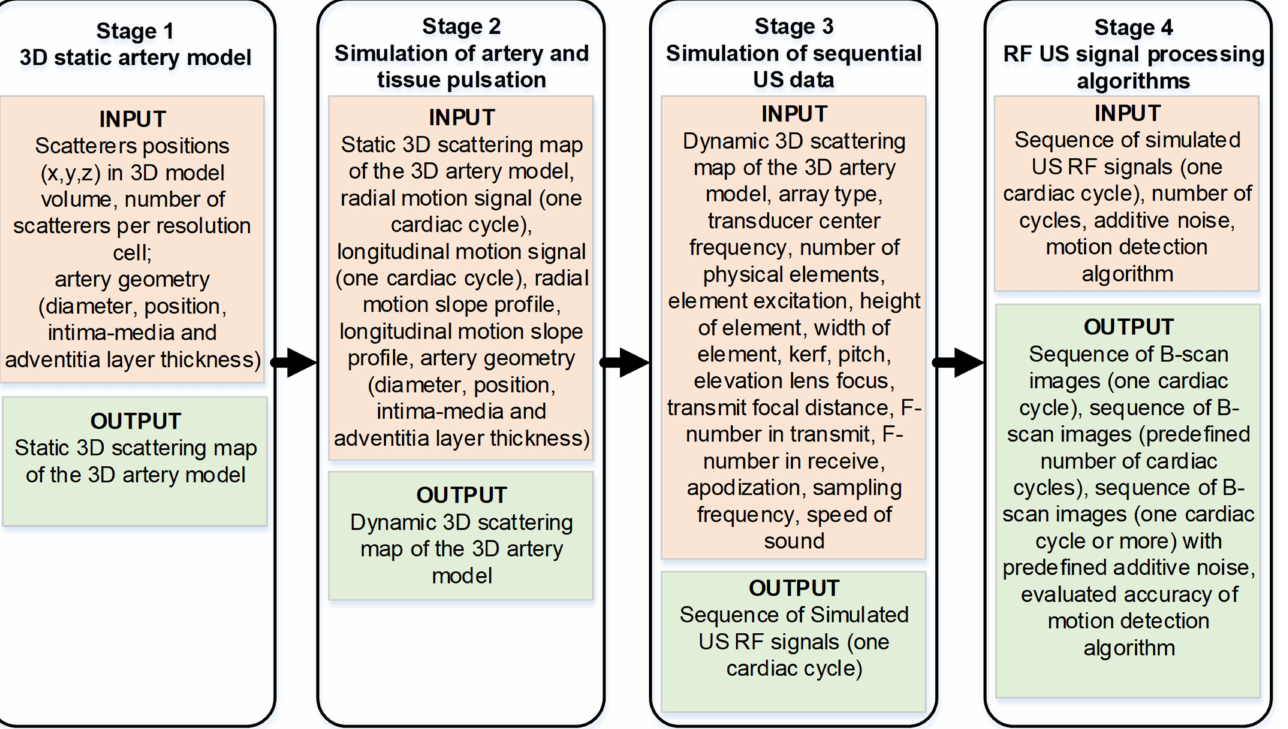
Figure 1. Overall simulation algorithm